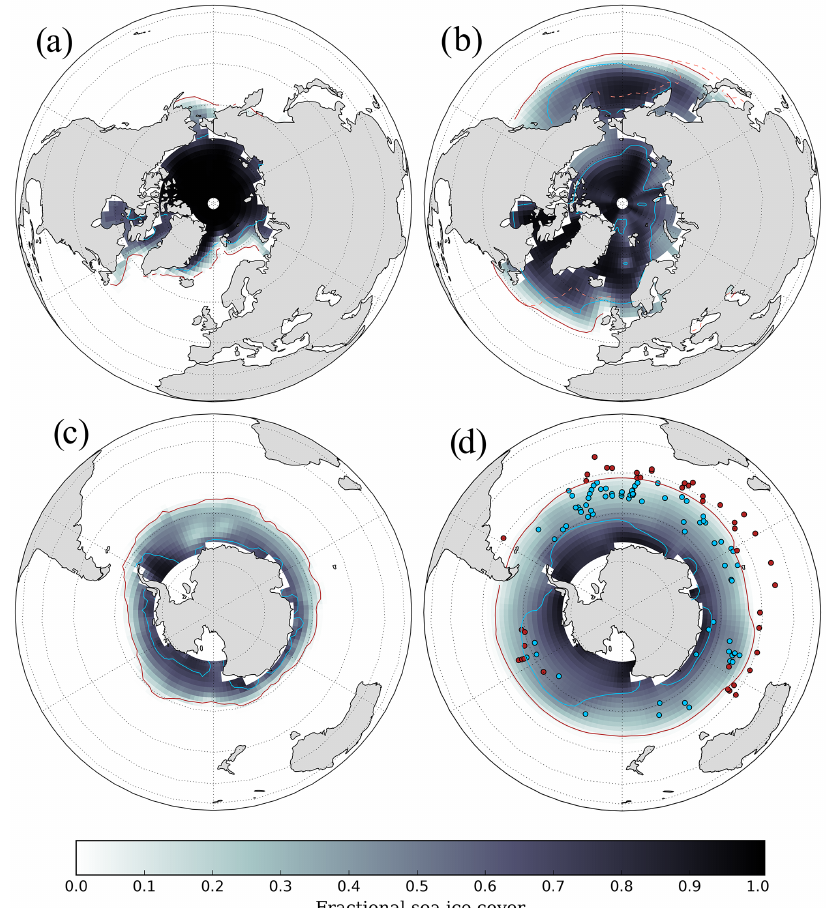
Figure 2. Annual average sea ice cover for (a) the Cpl-PI Northern Hemisphere, (b) the Cpl-LGM Northern Hemisphere, (c) the Cpl-PI Southern Hemisphere and (d) the Cpl-LGM Southern Hemisphere. The red and blue contour lines in each projection represent the maximum and minimum seasonal sea ice extents (where sea ice concentration equals 15% as per Gersonde et al., 2005). In (b) , the dashed orange contour line represents the maximum seasonal sea ice extent produced by the Institut Pierre Simon Laplace (IPSL) climate system model, which took part in the PMIP3 LGM experiment, and is broadly consistent with the results of other PMIP3 models. In (d) , the coloured markers represent locations were winter sea ice was deemed to have been present (blue) and absent (red) at the LGM according to Gersonde et al.